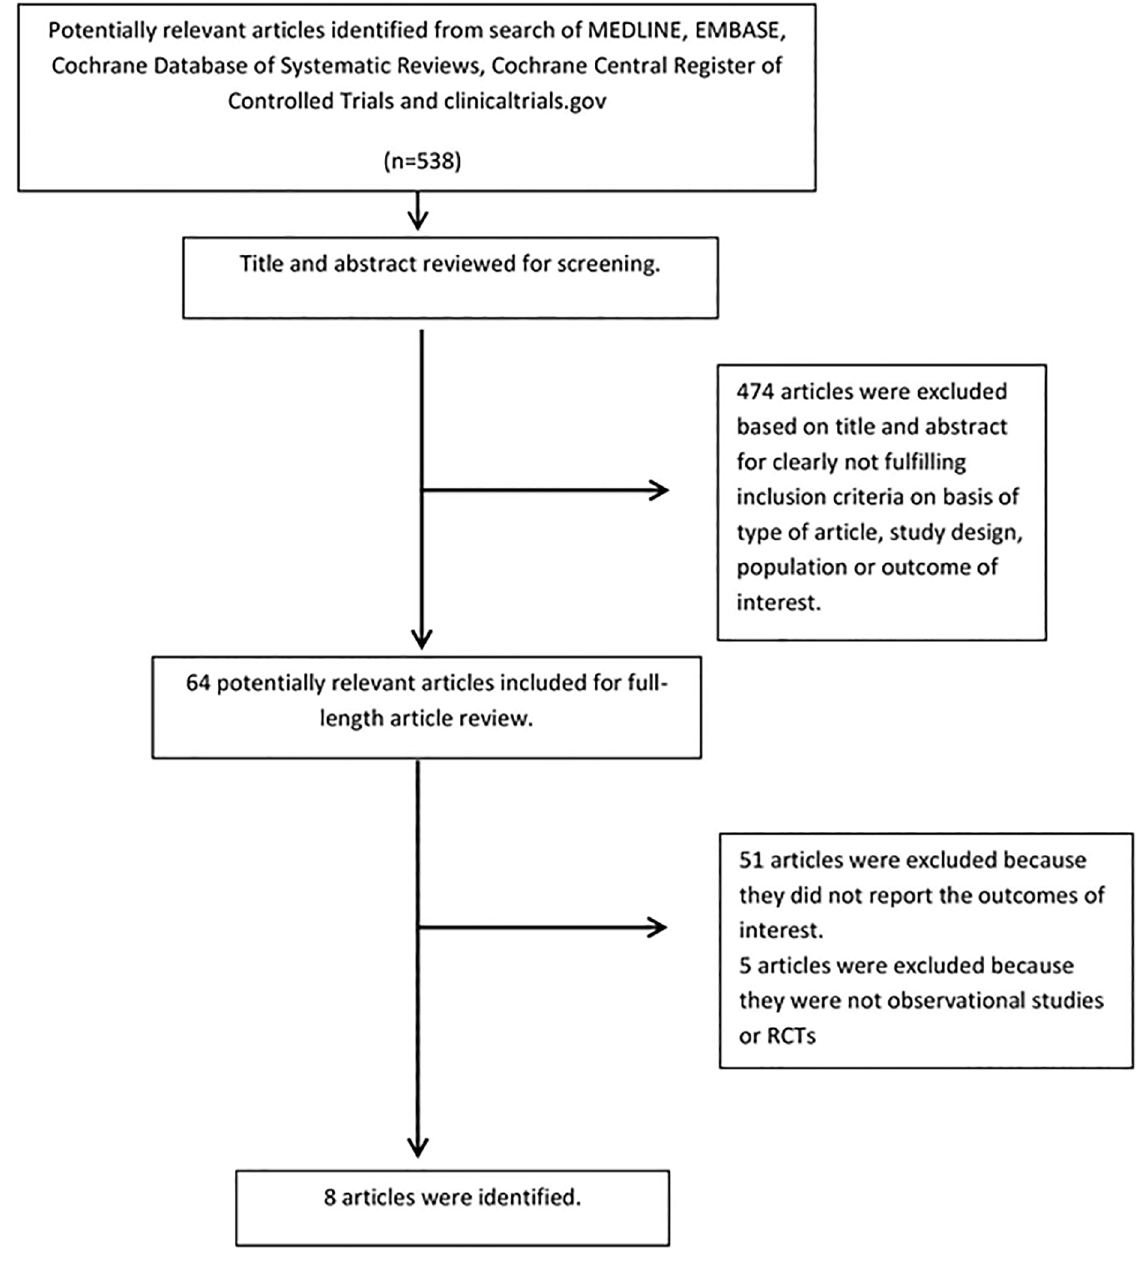
Fig 1. Outline of our search